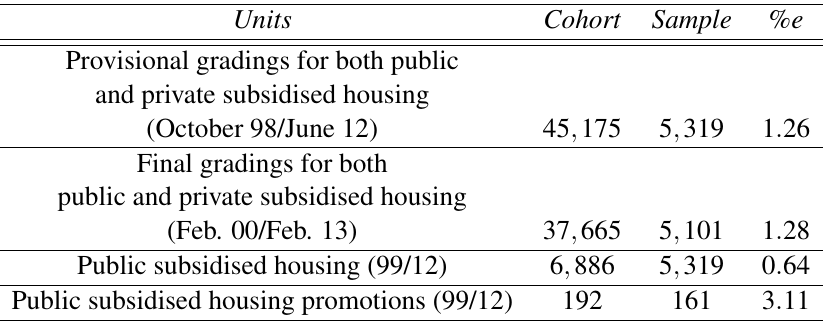
Table 4 Sample errors. Source: own